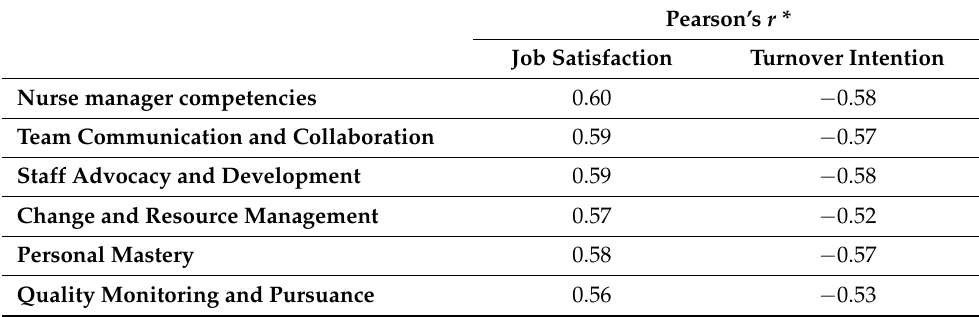
Table 4. Associations between nurse manager competencies and nurse